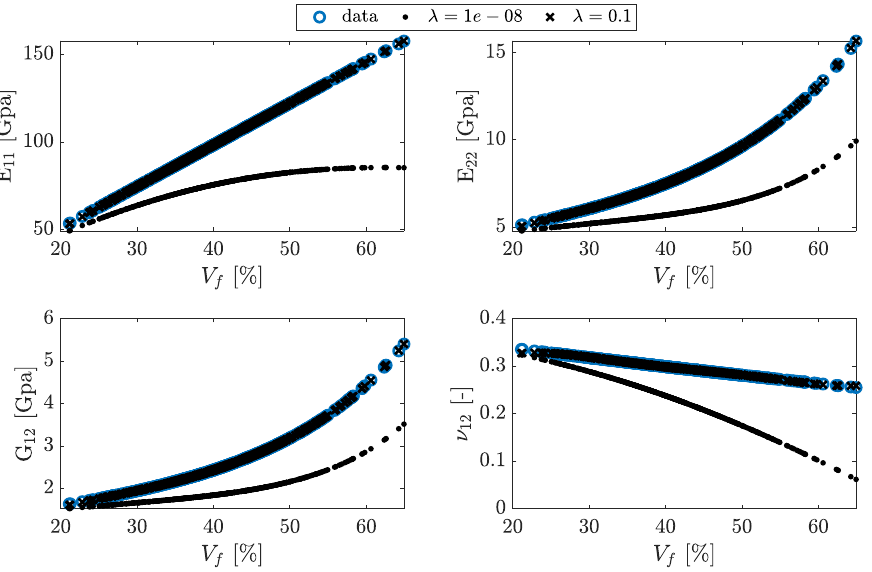
Figure 10. Data fitting models for λ ≈ 0 and the nonzero value of λ = 0.1. The zero value gives obviously huge error in parameter